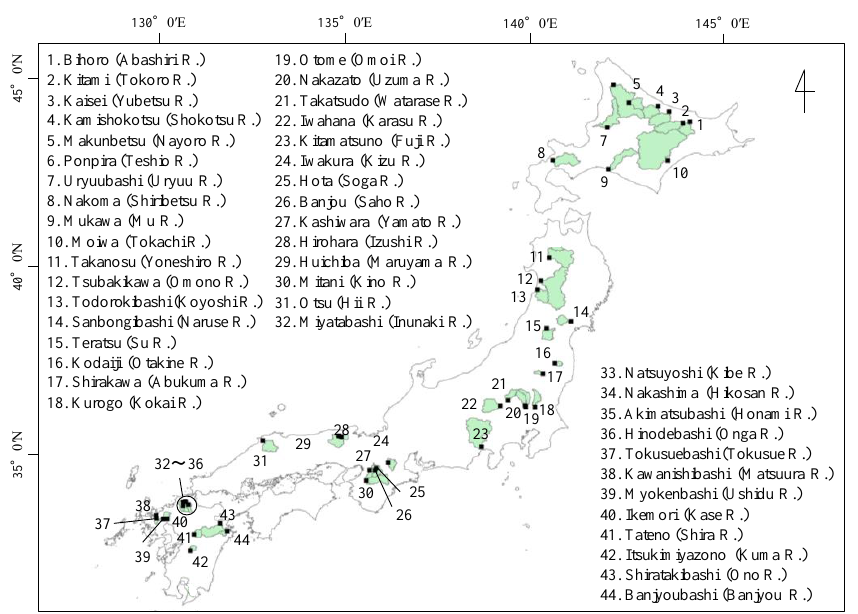
Figure 1. Location of the study site. In this study, I included watershed areas of 44 observation stations across the Japanese archipelago.